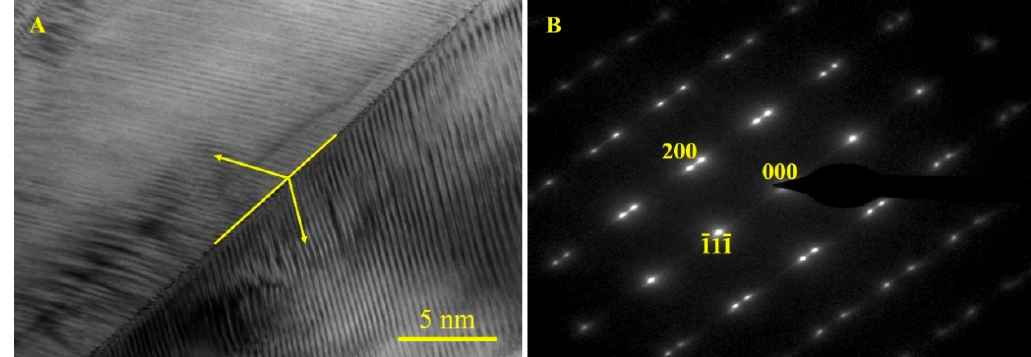
Figure 5. The TEM image ( A ) and SAED analysis ( B ) of martensite.